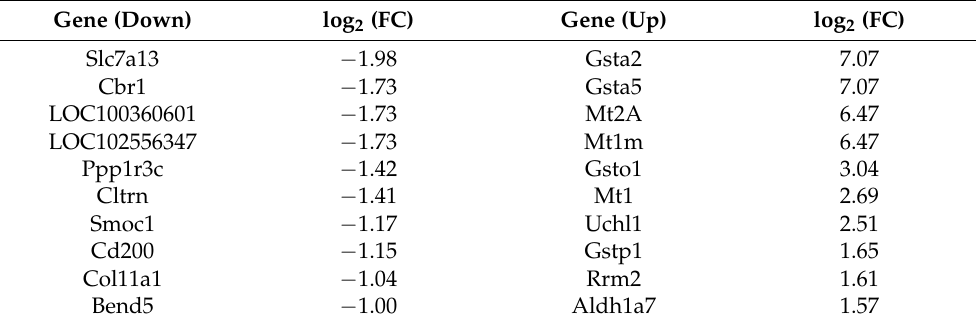
Table 3. The top 10 up- and downregulated differential expression genes from the 87 common genes for the different doses and exposure times in the in vivo and in vitro guinea pig data. FC, fold change.